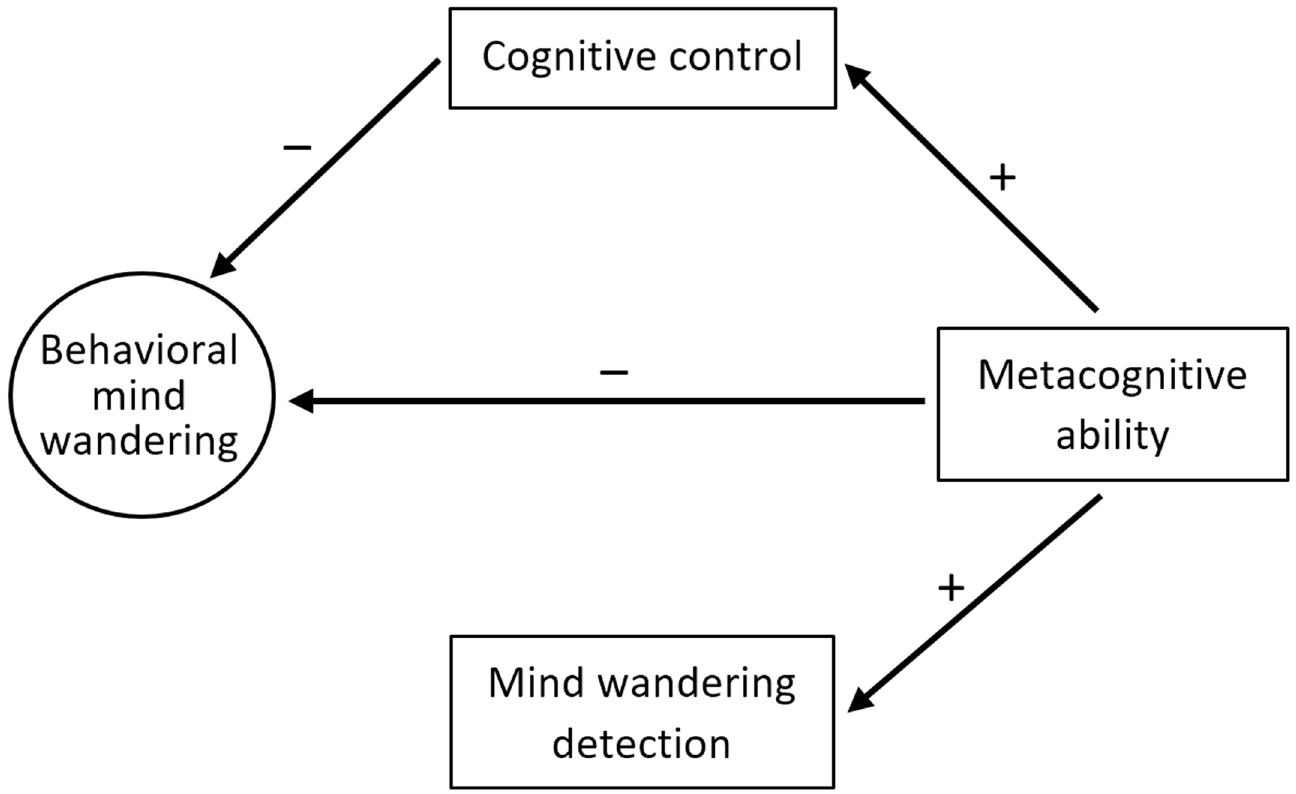
Fig 1. The predictions of the current